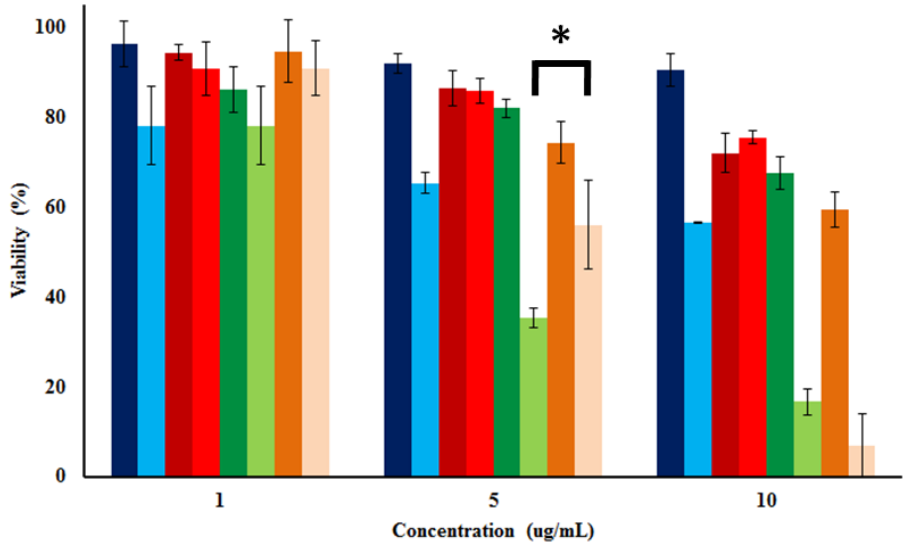
Figure 6. Cytotoxicity of AlClPc-MSNs ( dark blue ), cisplatin-MSNs ( dark red ), AlClPc/cisplatin-MSNs ( dark green ) and physical mixture of cisplatin/AlClPc molecules ( dark orange ) under dark conditions. Phototoxicity of AlClPc-MSNs ( light blue ), cisplatin-MSNs ( light red ), AlClPc/cisplatin-MSNs ( light green ) and physical mixture of cisplatin/AlClPc molecules ( light orange ) after red light exposure (570–690 nm; 89 mW/cm 2 ) for 20 min. Asterisk indicates p <